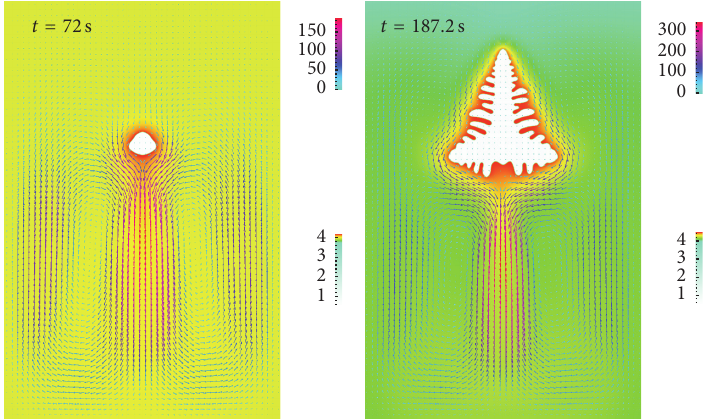
Figure 1: Two snapshots of the simulated flow field and solutal field for 𝑡 = 72 s and 187.2 s. The upper legend is for flow velocity with units of 𝜇 m/s and the lower legend is the weight percent of solute Cu (wt.%).